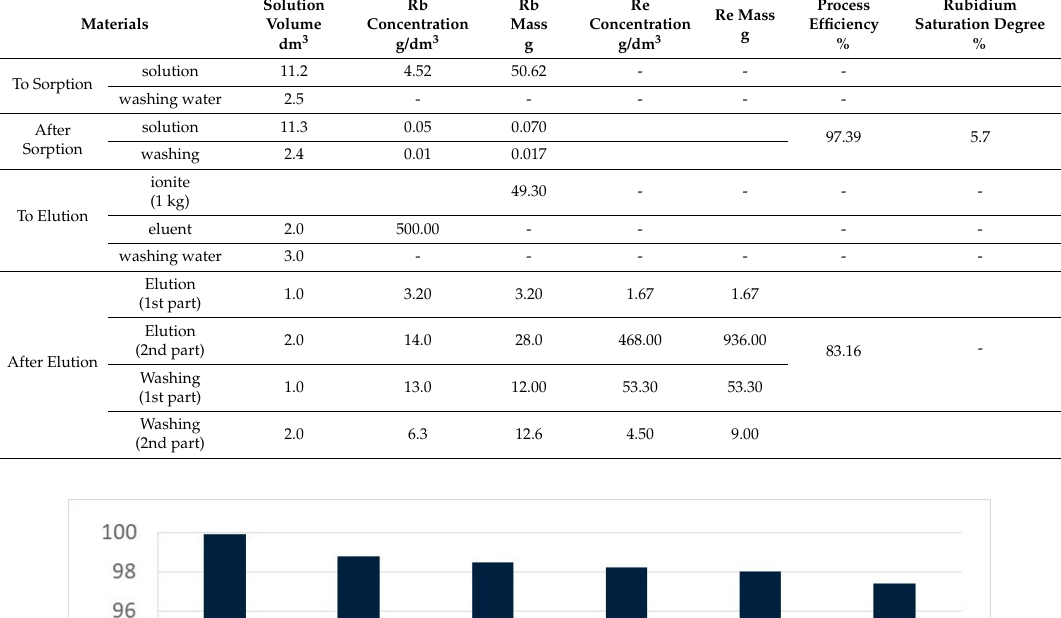
Table 14. Rubidium and rhenium sorption and elution mass balance—cycle VI.